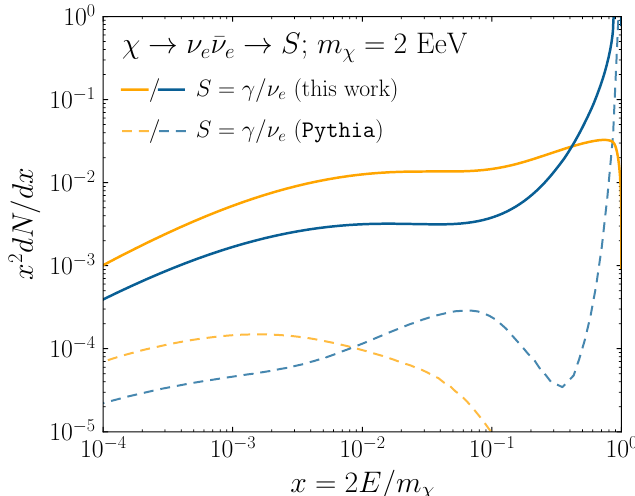
Figure 1 . The prompt electron neutrino and photon spectrum resulting from the decay of a 2 EeV DM particle to ν ¯ ν , as currently being searched for at IceCube [5]. Solid curves represent the e e results of this work, and predict orders of magnitude more flux at certain energies than the dashed results of Pythia 8.2, one of the only existing methods to generate spectra at these masses. In both cases energy conservation is satisfied: there is a considerable contribution to a δ -function at x = 1 , associated with events where an initial W or Z was never emitted and thus no subsequent shower developed. Large disagreements are generically observed at these masses for electroweak dominated channels, while the agreement is better for colored initial SM